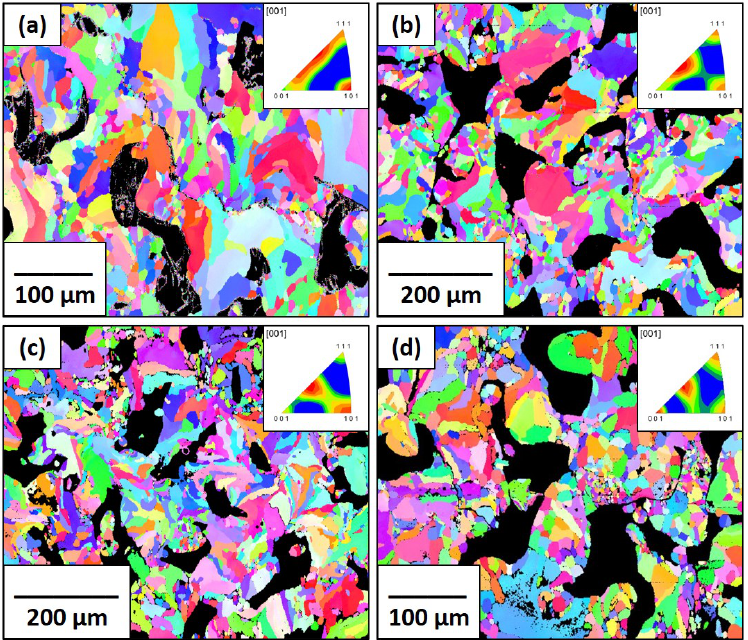
Figure 4. EBSD IPF maps and corresponding IPFs for the pure molybdenum specimens in the observa- tion direction for all four scan speeds: ( a ) 100 mm/s; ( b ) 200 mm/s; ( c ) 400 mm/s; ( d ) 800